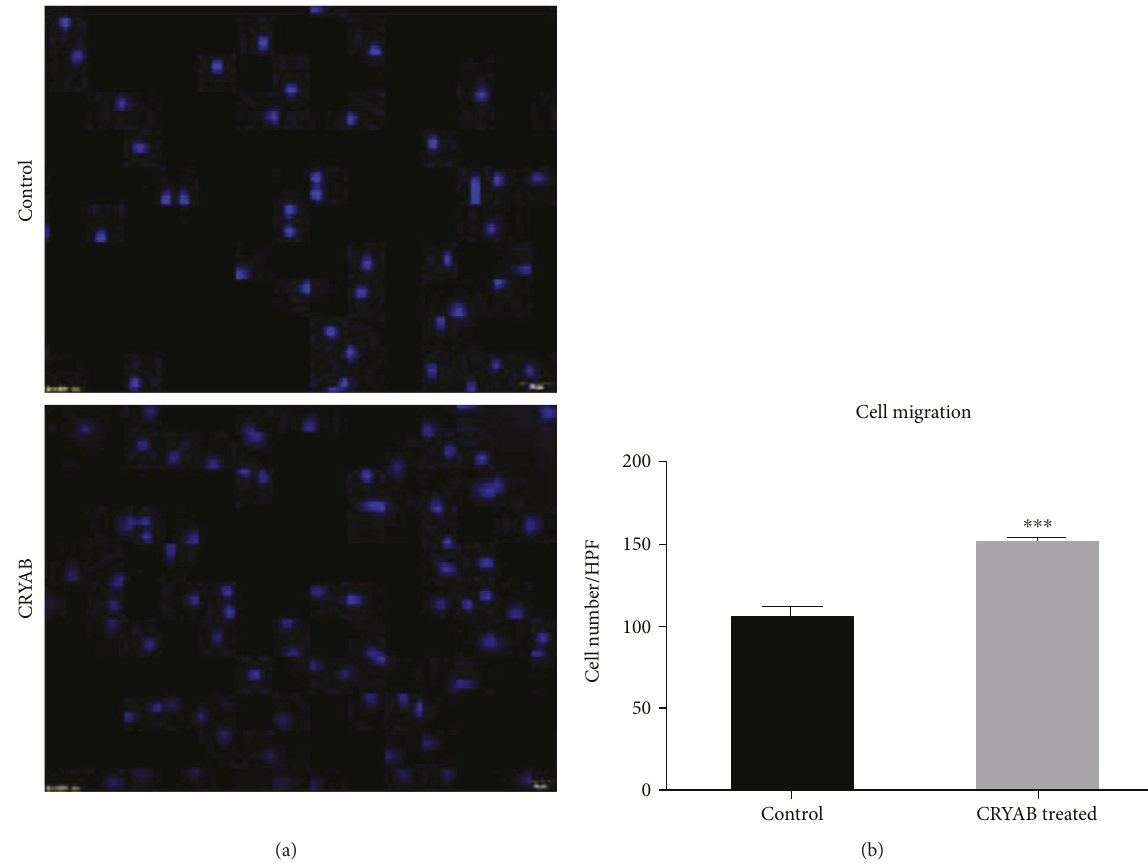
Figure 2: (a, b) CRYAB induced migration in TM cells. TM cell migration in response to CRYAB treatment was measured using a transwell assay (100x magni fi cation). The amounts were assessed by the mean number of migrated cells. The number of migrated cells per high-power fi eld (HPF) was shown. ∗∗∗ p < 0 001 versus the untreated control.